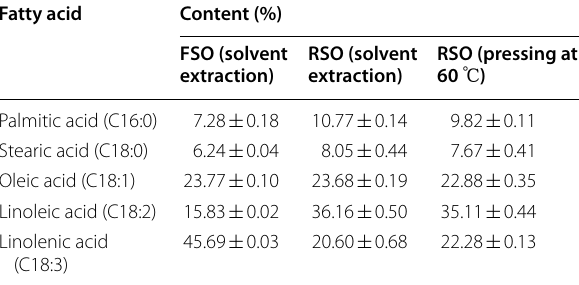
Table 5 Fatty acid composition of rubber seed oil (RSO) and flaxseed oil (FSO) Fatty acid